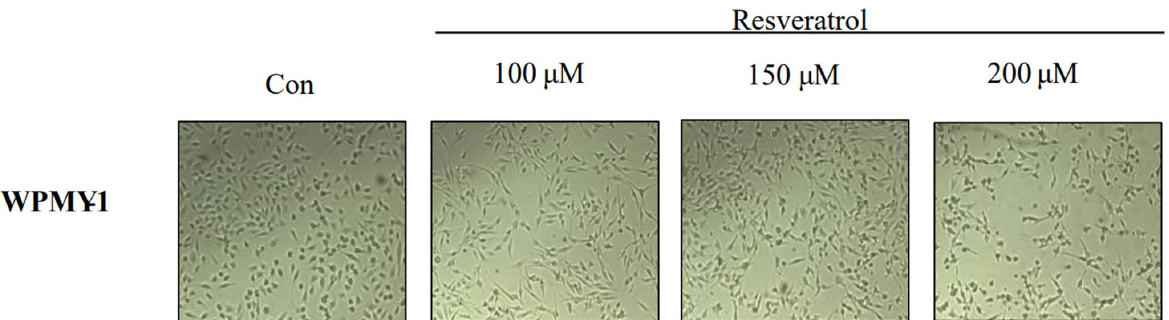
Figure 2. Cellular morphology in WPMY-1 cells treated with resveratrol. The cells were treated without or with various resveratrol concentrations (0, 100, 150, and 200 μM) for 24 h. The morphological change of WPMY-1 cells was imaged using an inverted microscope (original magnification x200).